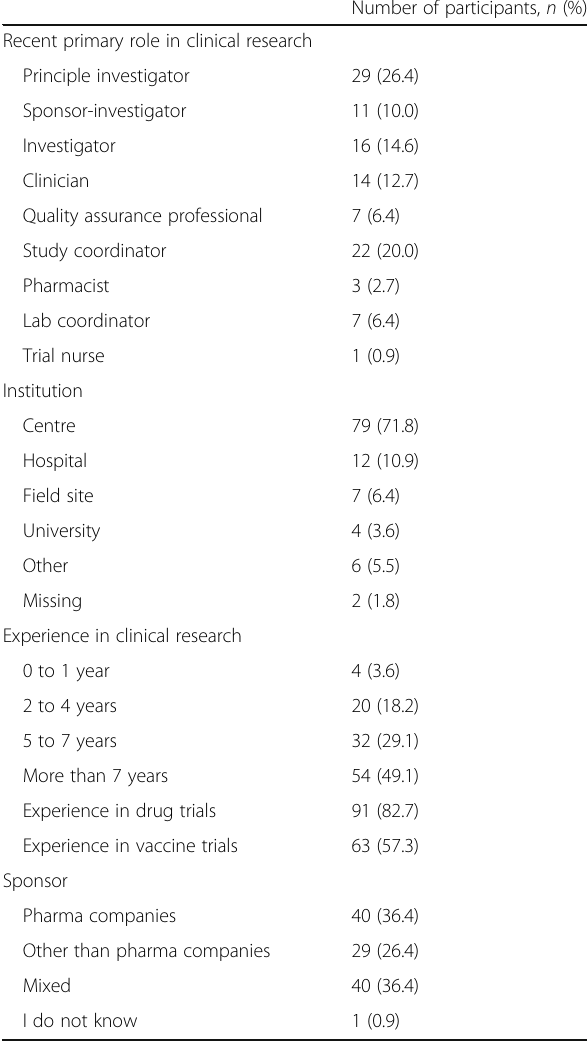
Table 3 Role and experience of survey